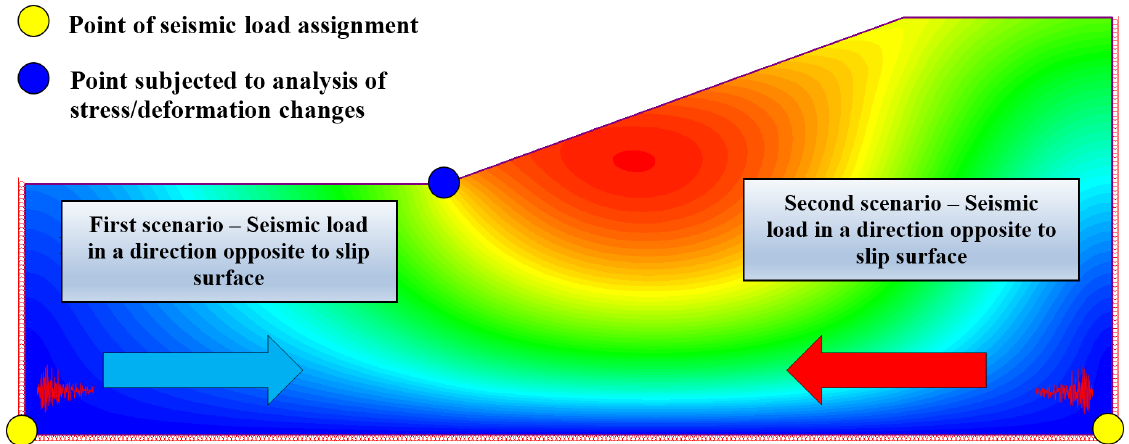
Figure 6: Analysed variants of seismic load